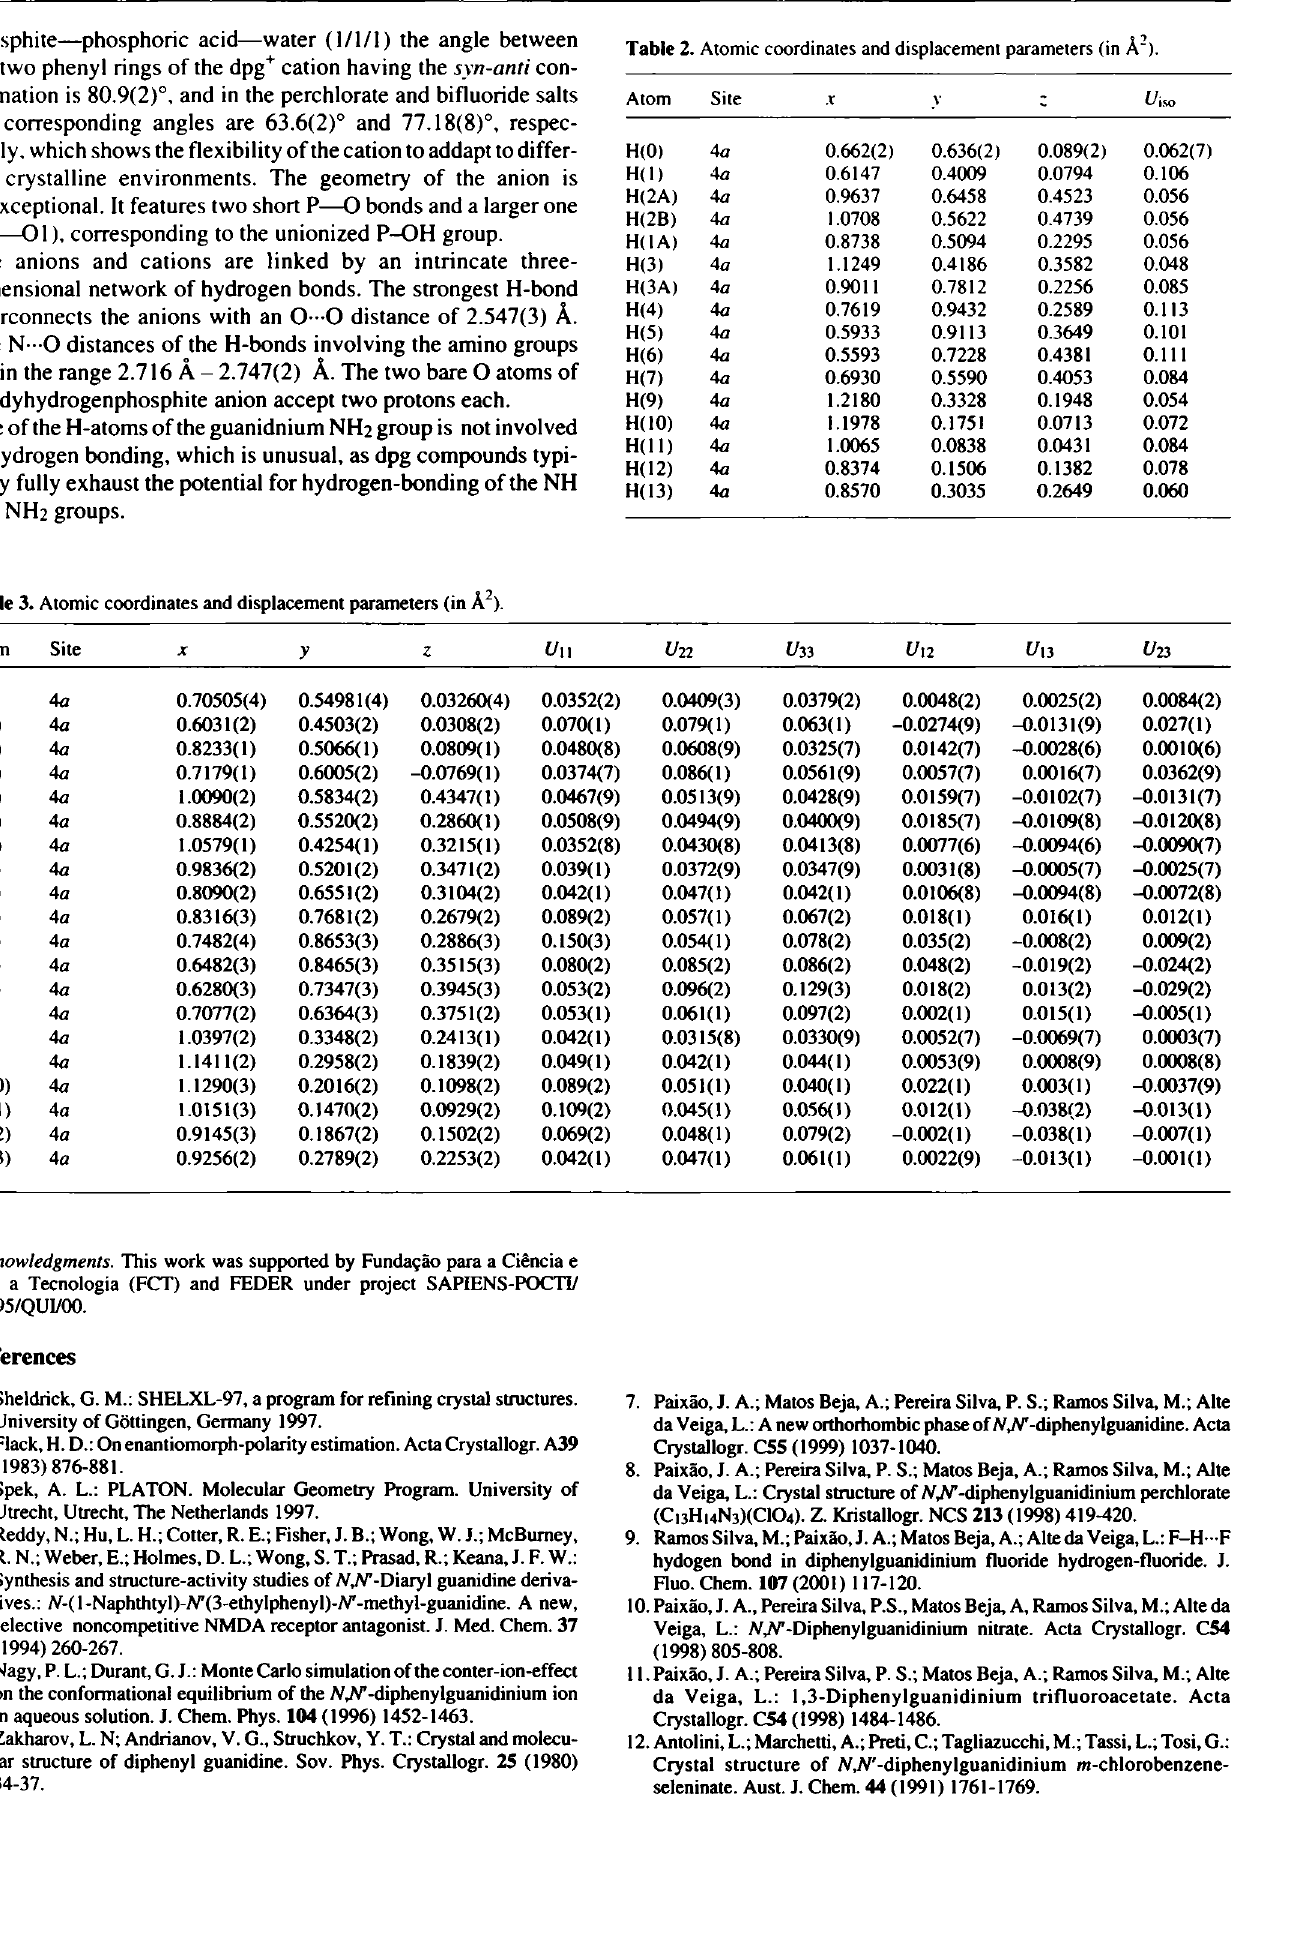
Table 2. Atomic coordinates and displacement parameters (in A 3